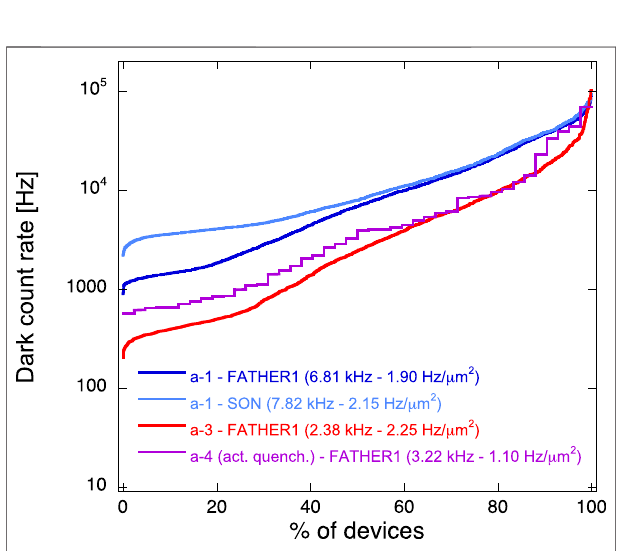
FIGURE 11 | Coincidence DCR cumulative distribution curves for pixels from an a -1 structure in a dual-layer sample. The curves were obtained for different values of the bias voltage applied to the SPADs. The coincidence window duration is 2